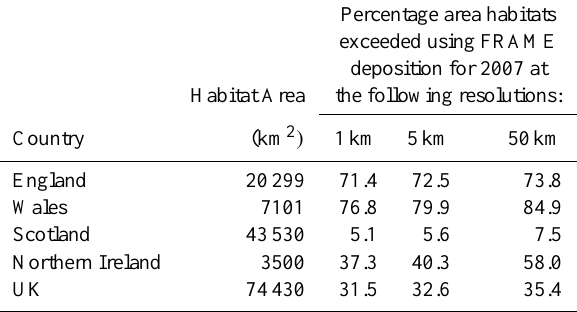
Table 3a. National scale summary statistics for habitat areas with Table 3b. National scale summary statistics for habitat areas with exceedance of the critical load for nutrient nitrogen deposition by exceedance of the critical load for nutrient nitrogen deposition by region. habitat Percentage area habitats exceeded using FRAME